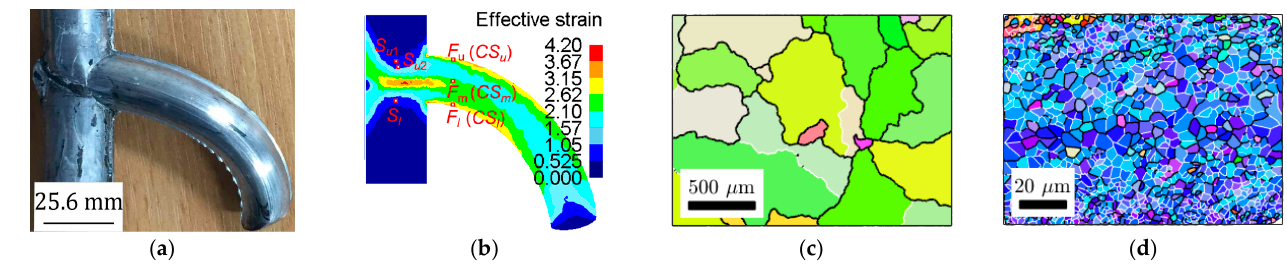
Figure 28. ( a ) Characterized curved profile, ( b ) selected locations for characterization and effective strain, ( c ) microstructure of the billet cross-section, ( d ) microstructure of the profile cross-section. Reproduced with permission from ref. [104]. Copyright 2019 Elsevier Ltd.